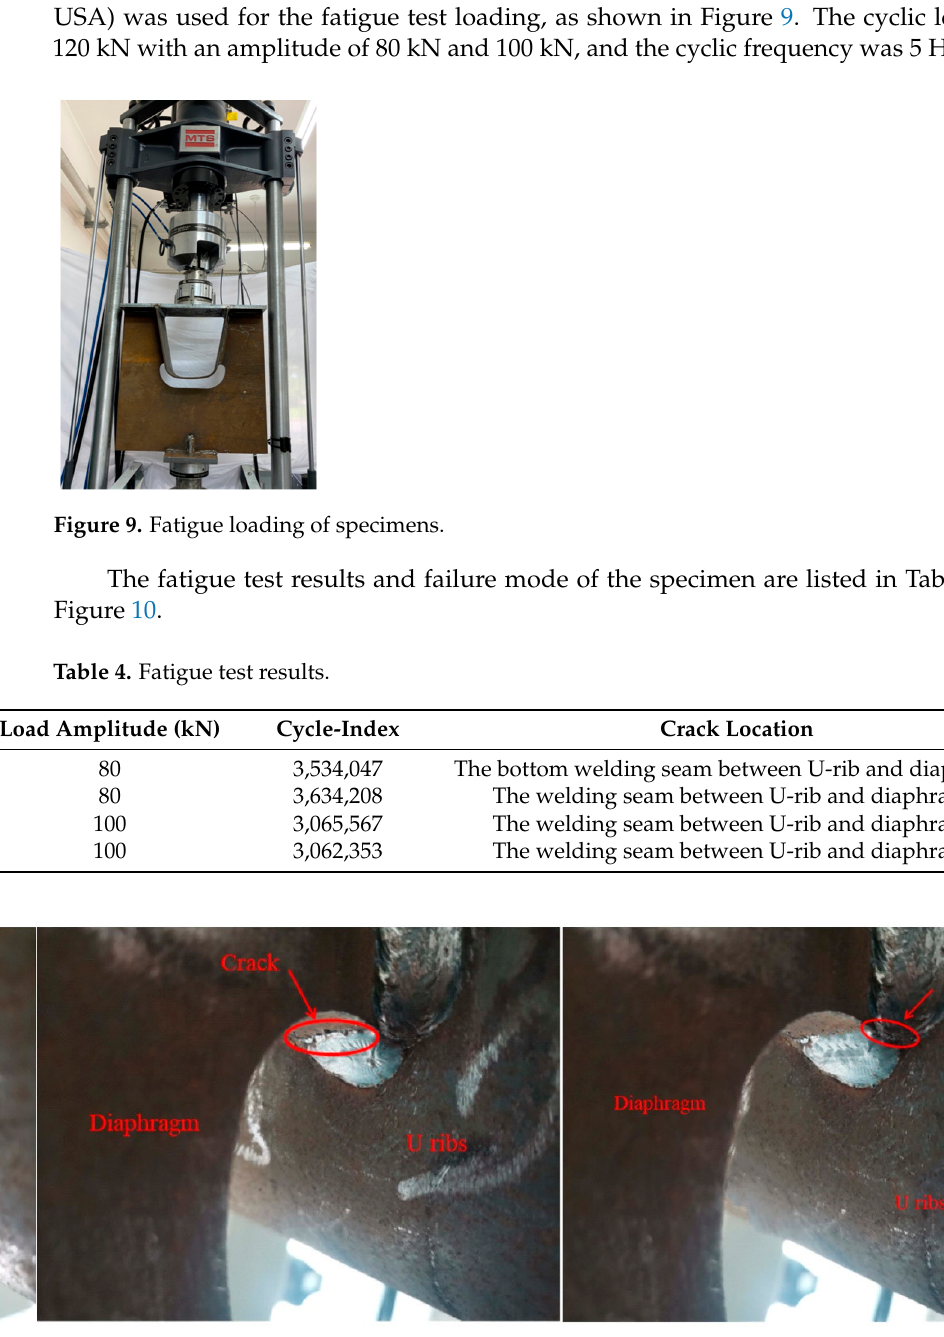
Figure 10. Failure mode of specimens.